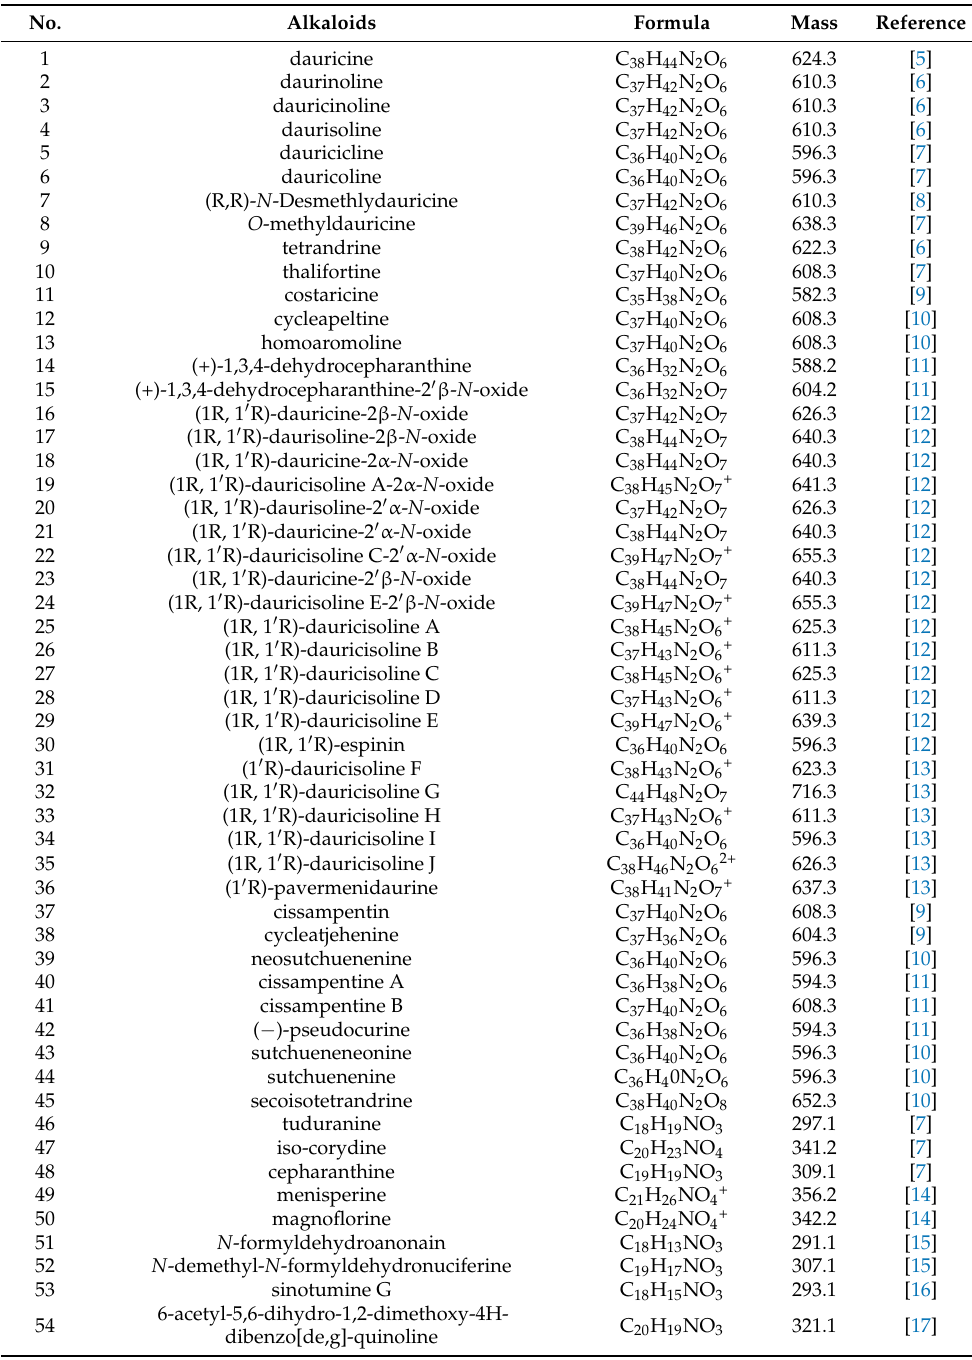
(Table 1: 1–45), apomorphins and oxidized isoapomorphins (Table 1: 46–82), morpholines (Table 1: 83–91), proberberberine and berberine (Table 1: 92–98), and other classes of alka- loids (Table 1: 99–117). Among them, bibenzylisoquinolines, apomorphins, and oxidized isoapomorphins alkaloids are the most distributed among the alkaloid components of M. Rhizoma . Table 1. Alkaloids of M. Rhizoma